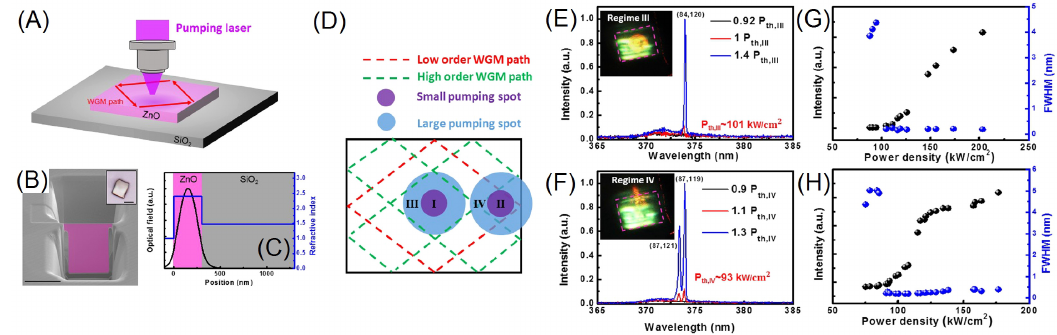
Figure 10: (A) Schematic plot of ZnO membrane microcavity and the configuration of optical measurement. (B) SEM image of suspended ZnO membrane with false color for clarity. Inset shows the optical microscope image of ZnO membrane on the SiO 2 substrate. The scale bar in both the main figure and the inset figure is 10 µ m. (C) Refractive index and optical field distribution along the vertical direction of ZnO microcavity. (D) Schematic plot of four pumping schemes and the optical paths for WGMs. (E–H) Measured spectra and peak intensity and linewidth versus pumping intensity at regime III and IV pumping condition. The insets in (E) and (F) display the optical microscope images of pumping spot on ZnO microcavity of regime III and regime IV, respectively. Reproduced with permission from Ref. [122]. SEM: secondary electron microscope; WGMs: whispering-gallery